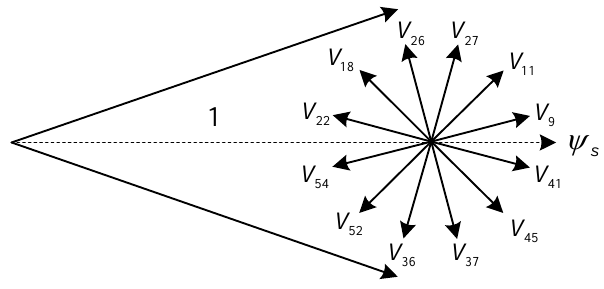
Figure 10. Space voltage vector selection of sector 1.